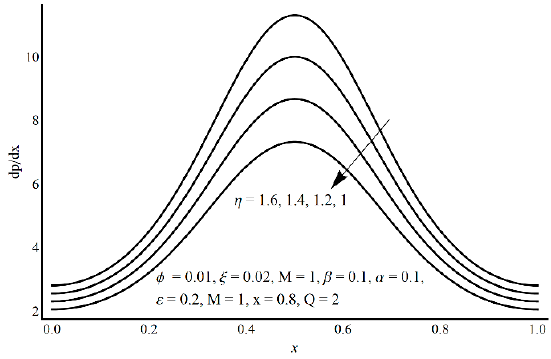
Figure 8. Pressure gradient at various values of variable ξ .